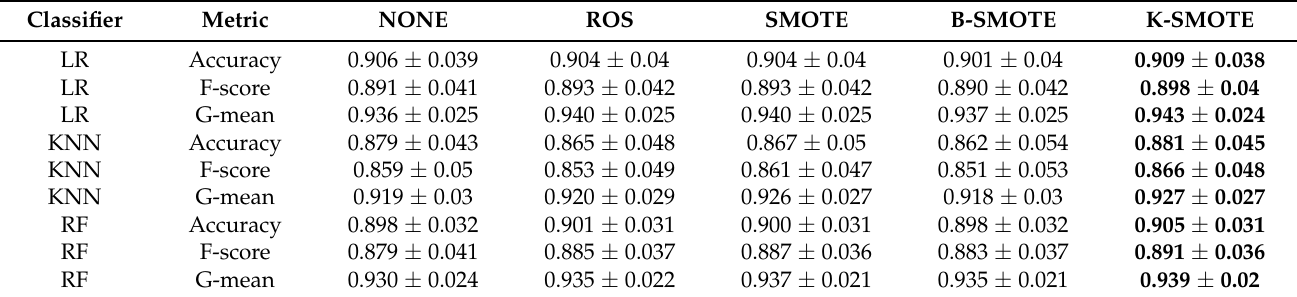
Table 3. Mean cross-validation scores of oversamplers.